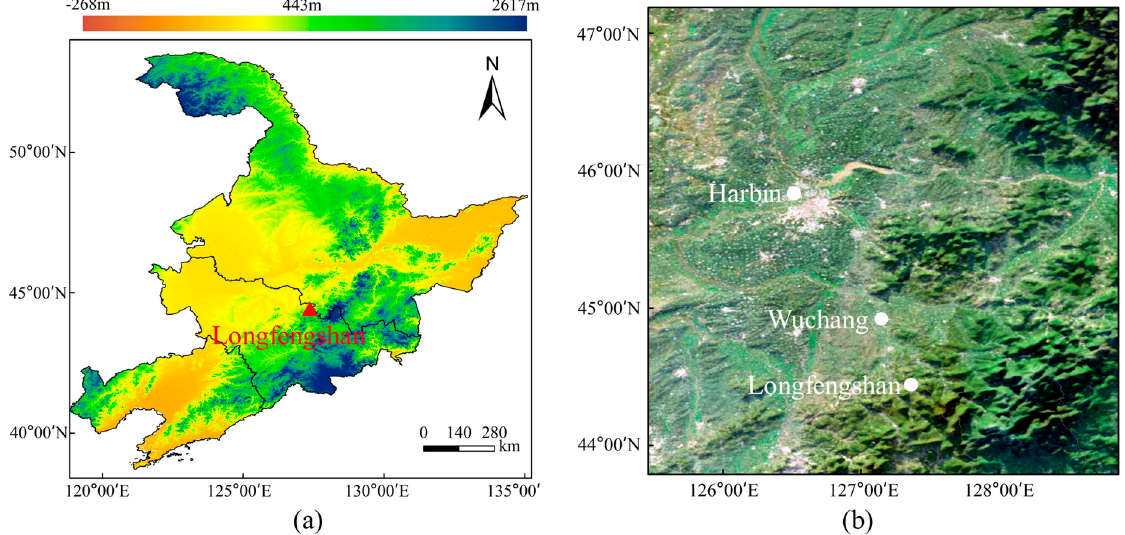
Figure 1. ( a ) The elevation map of Longfengshan regional atmospheric background station. ( b ) The major neighborhood cities around the LFS station (the background image is from the Sentinel − 2 satellite).